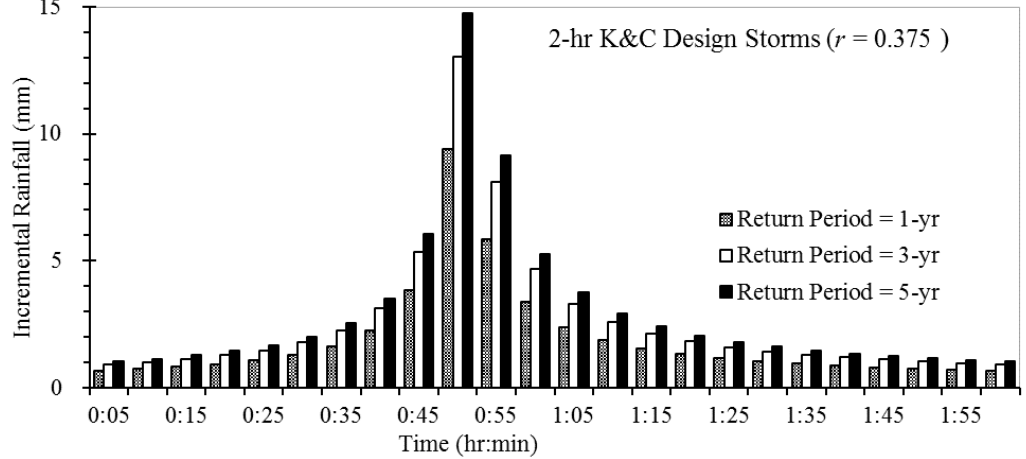
Figure 4. Two ‐ hour Beijing K&C design rainfall distributions for one ‐ , three ‐ , and five ‐ year return Figure 4. Two-hour Beijing K&C design rainfall distributions for one-, three-, and five-year periods. return